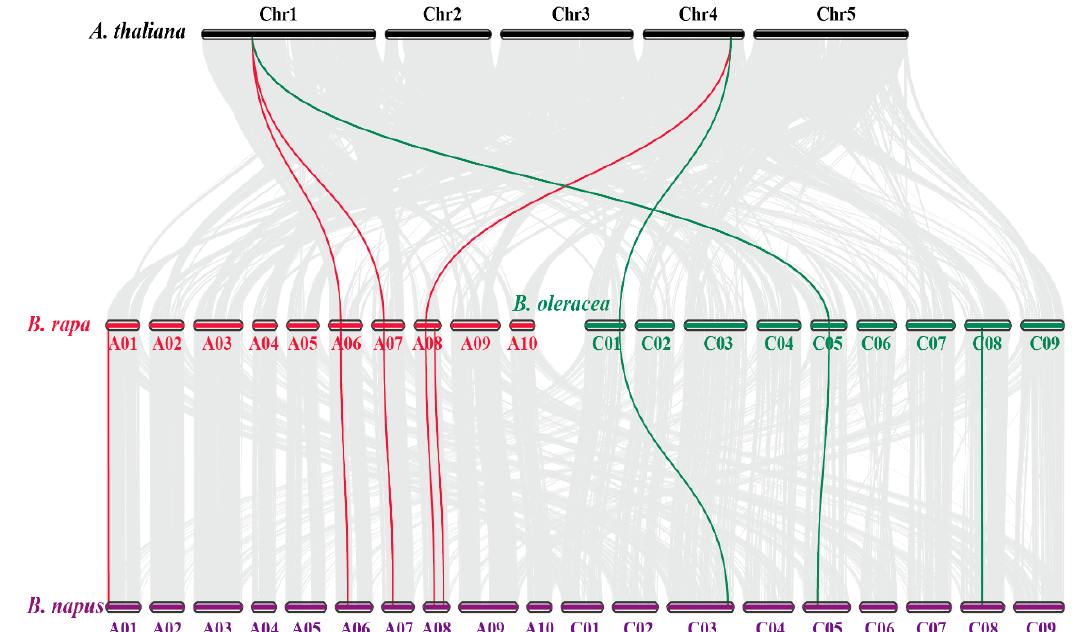
Figure 3. Synteny analysis of CAT genes in B. napus, B. rapa, B. oleracea, and A. thaliana chromosomes. Grey lines in the background show the collinear blocks within rapeseed and other plant genomes, while the red and green lines highlight the syntenic CAT gene pairs. Genes positioned on the B. napus A genome are syntenic with B. rapa and A. thaliana , while genes positioned on the B. napus C genome are syntenic with B. oleracea and A. thaliana .